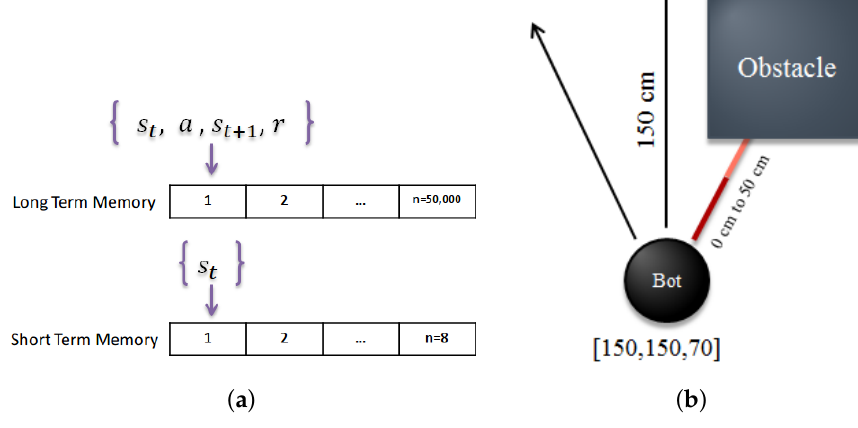
Figure 3. Memory and reward calculation. ( a ) Long-term and short-term memory used in our algorithm; ( b ) Range sensors used for reward calculation, adapted from